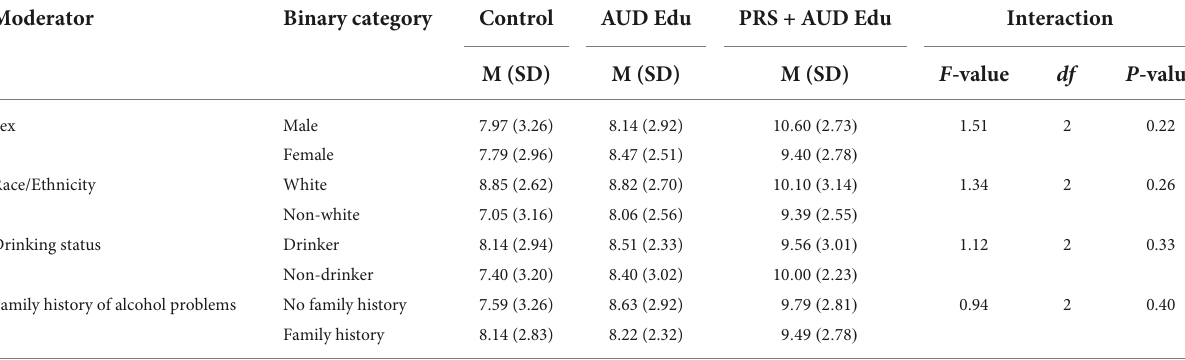
TABLE 4 Results of two-way ANOVAs examining interactions between the study condition and demographic